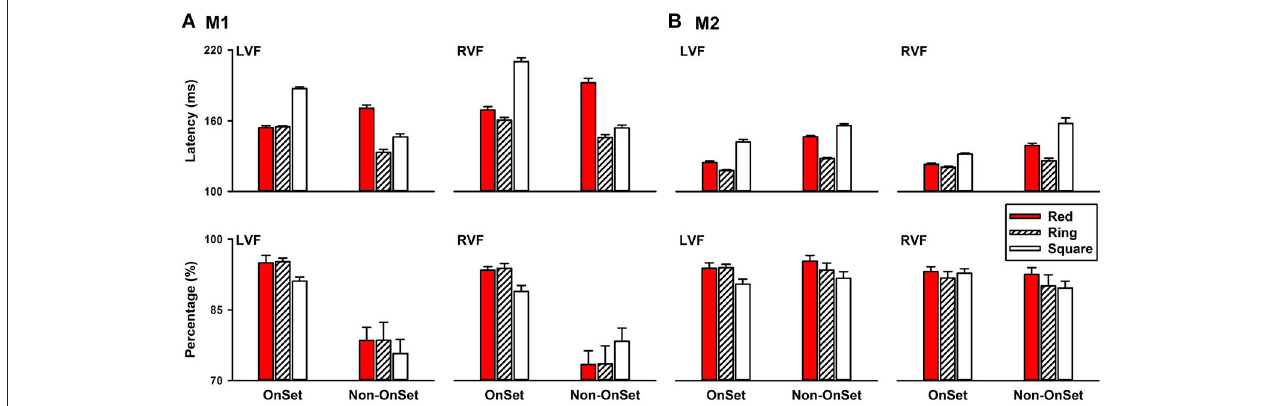
FIGURE 6 | Saccade latencies of detecting a change in color, local features and the global feature in the left, right, upper, and down visual fields (A) , M1; (B) , M2.